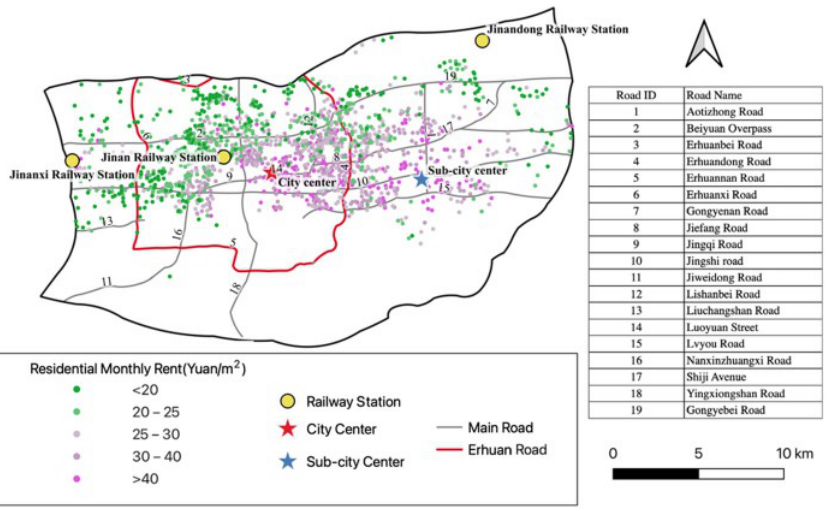
Figure 2. The spatial distribution pattern of residential rent levels in the main urban area of Jinan.